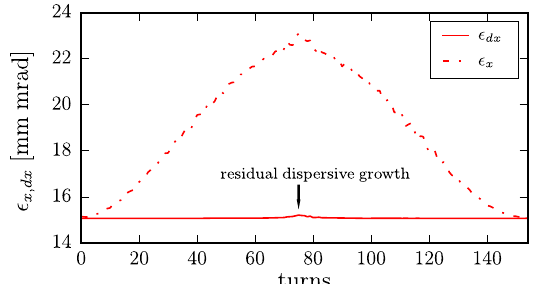
FIG. 6. The evolution of horizontal emittance ϵ ized horizontal emittance ϵ longitudinal phase